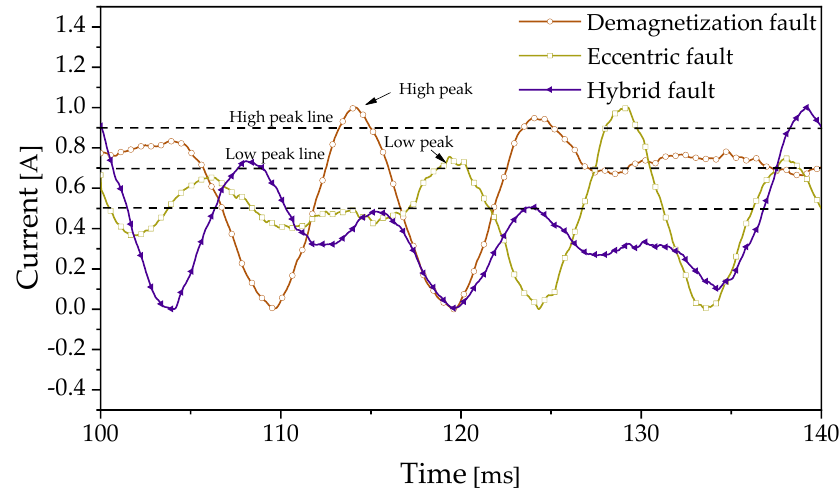
Figure 6. Normalized and MBCS residual value of different faults.